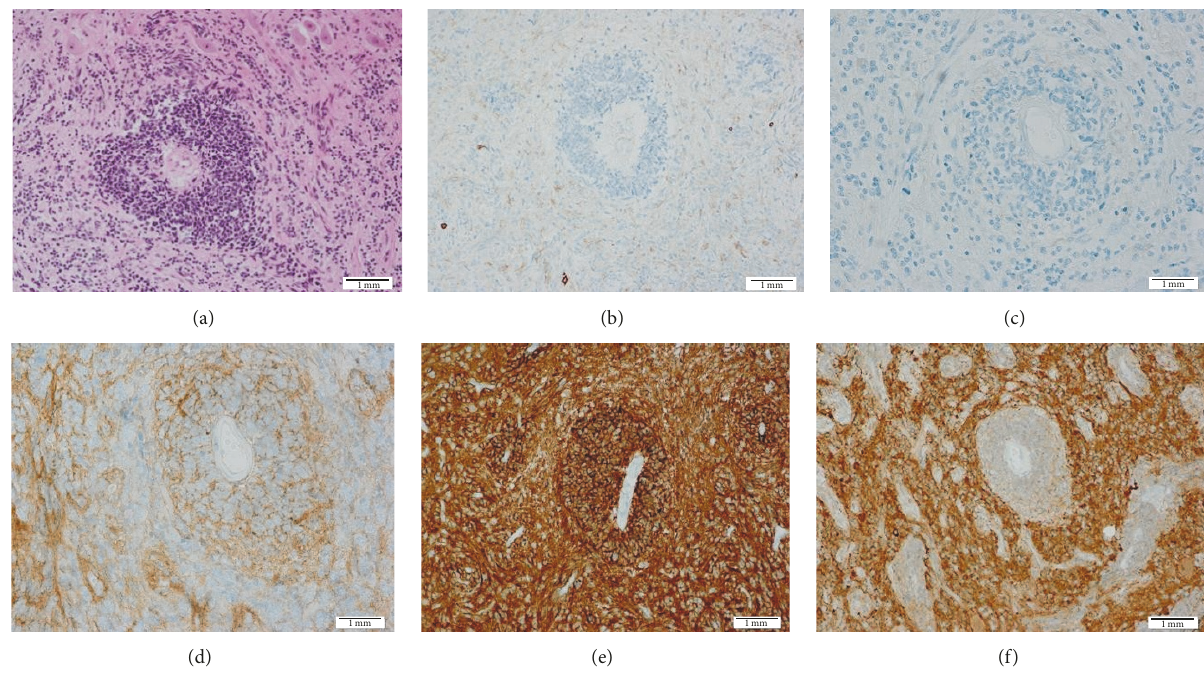
Figure 2: (a) H&E stain illustrating the primitive cells and the peculiar angiocentric pattern of distribution. (b) Immunohistochemical stain with CD45 (LCA) showed absence of immunoreactivity excluding lymphoma. (c) Pancytokeratin immunohistochemical stain was nonimmunoreactive excluding a metastatic carcinoma. ((d) and (e)) CD56 and CD99 immunohistochemical stains showed strong membranous pattern of immunoreactivity of the tumor cells. (f) Synaptophysin showed weak immunoreactivity.